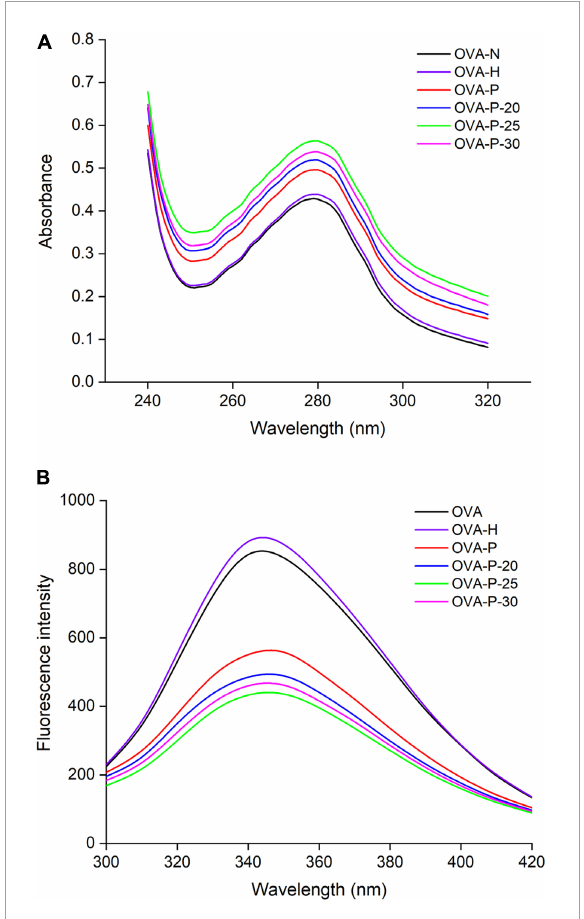
FIGURE4 Changes in ultraviolet (UV) absorption (A) and intrinsic fluorescence spectra (B) of the ovalbumin (OVA)